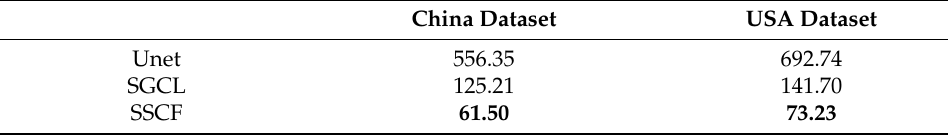
Table 3. Time cost (seconds) of each